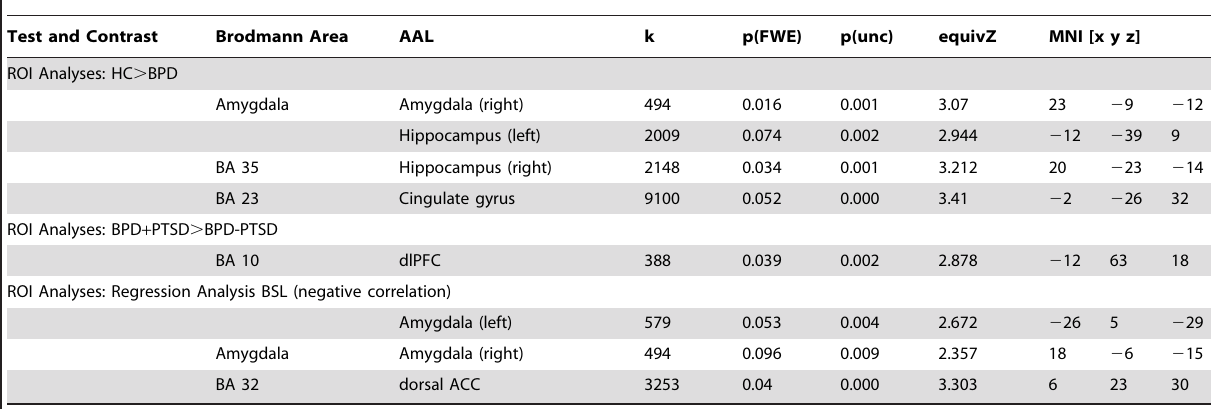
Table 1. Results of ROI analyses of gray matter volume.